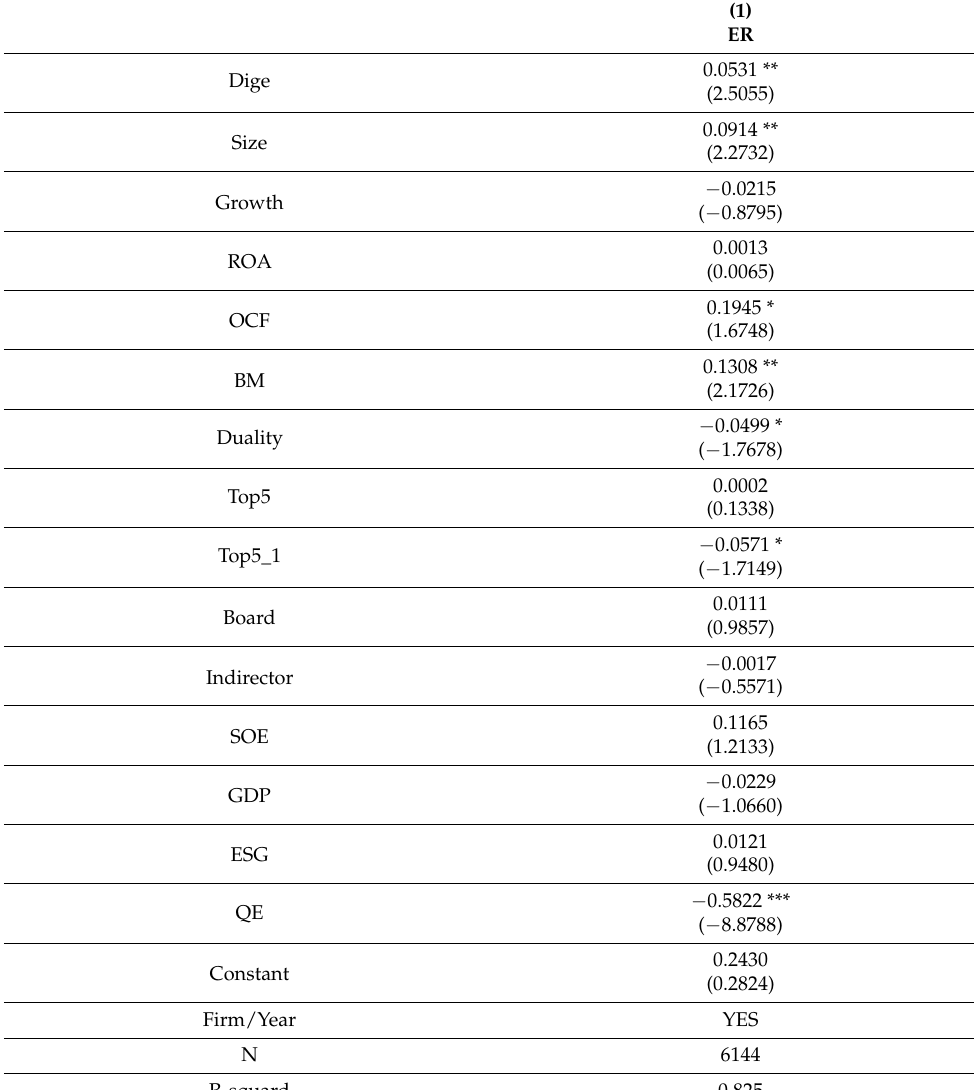
Table 7. Control ESG investment and QE policy.